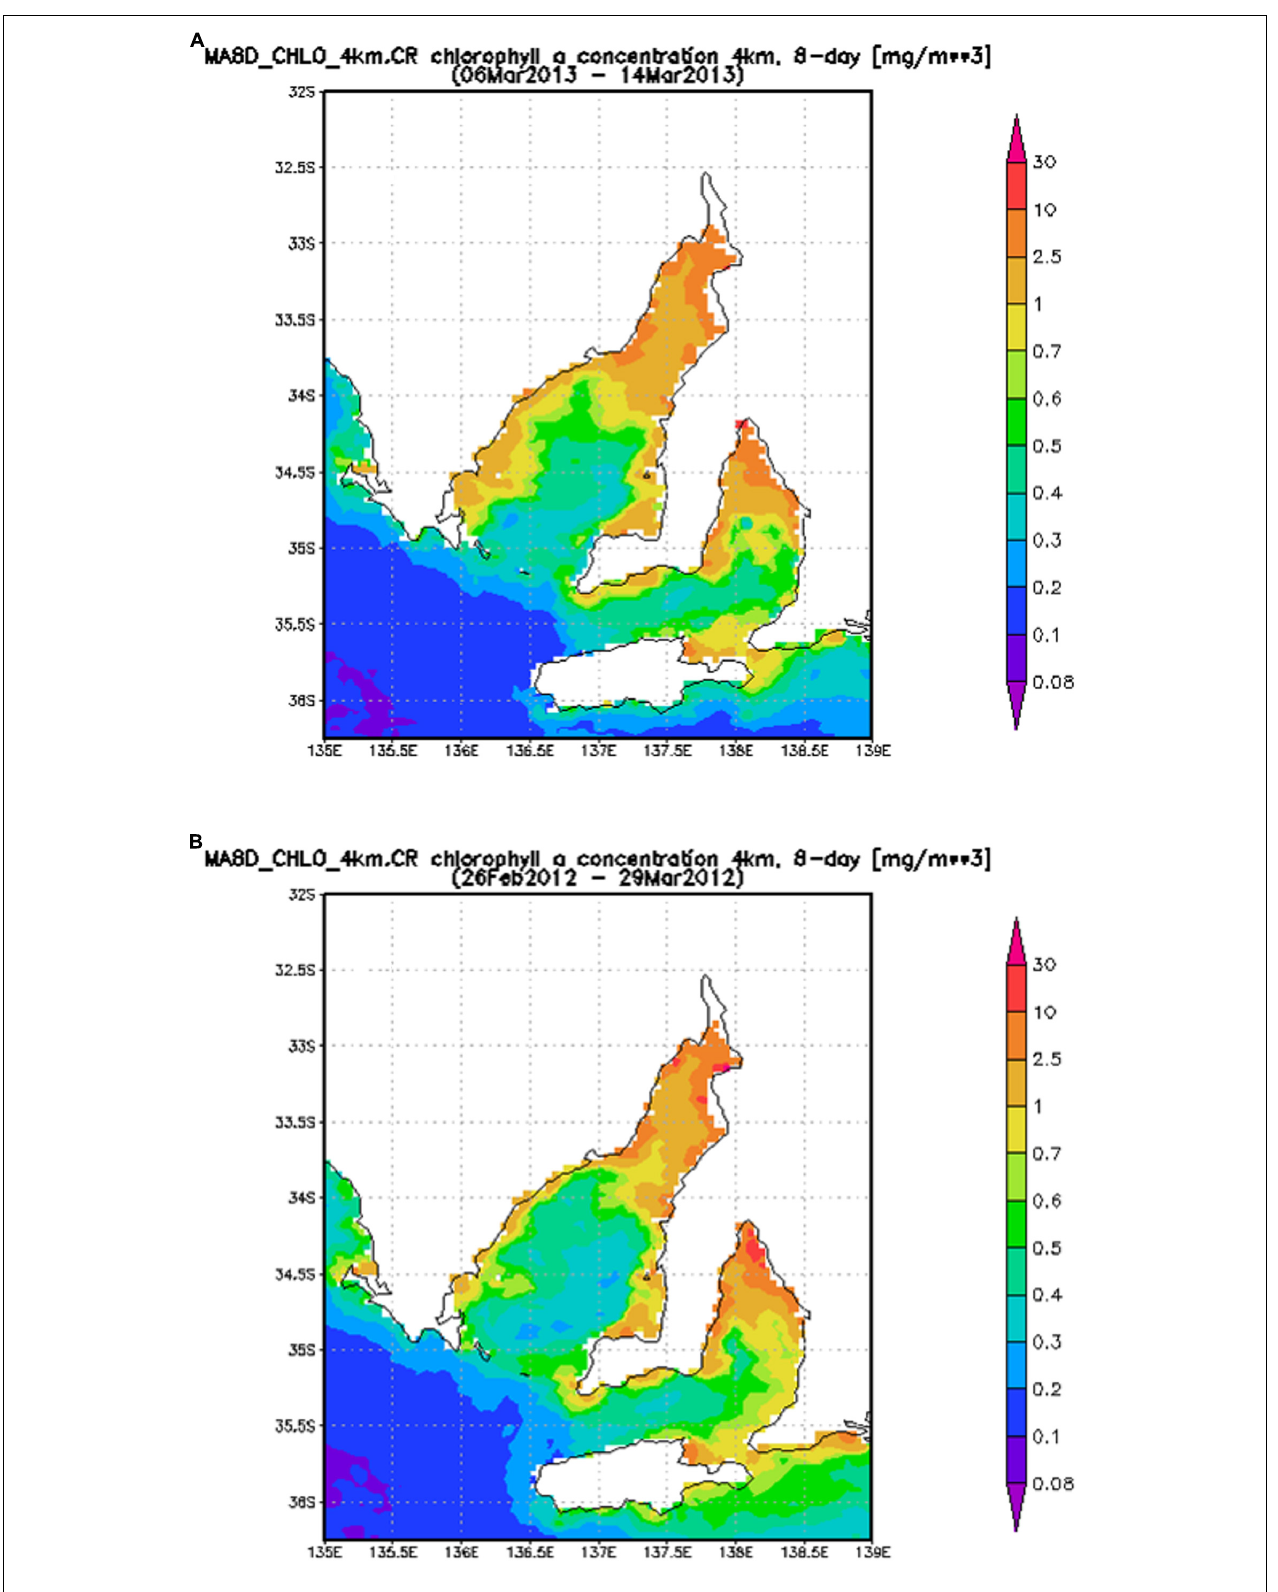
FIGURE 3 | Average chlorophyll concentration (mg m 3 ) from 6 to 14 March 2013 (A) and 26 February to 14 March 2012 (B) .